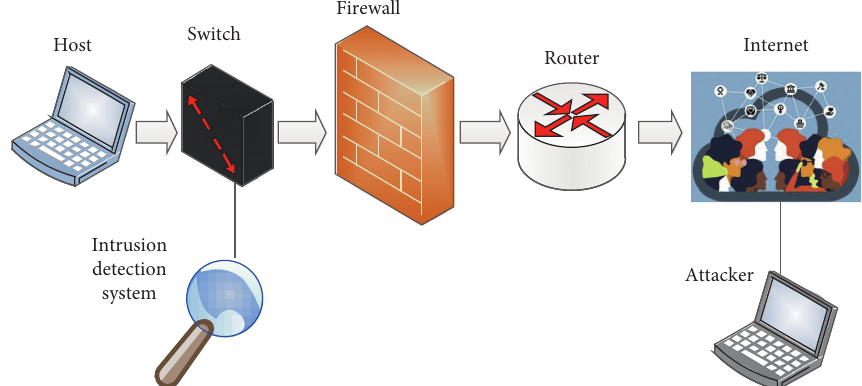
Figure 1: Typical system of intrusion detection positioned to block the host device from abnormal network traffic.